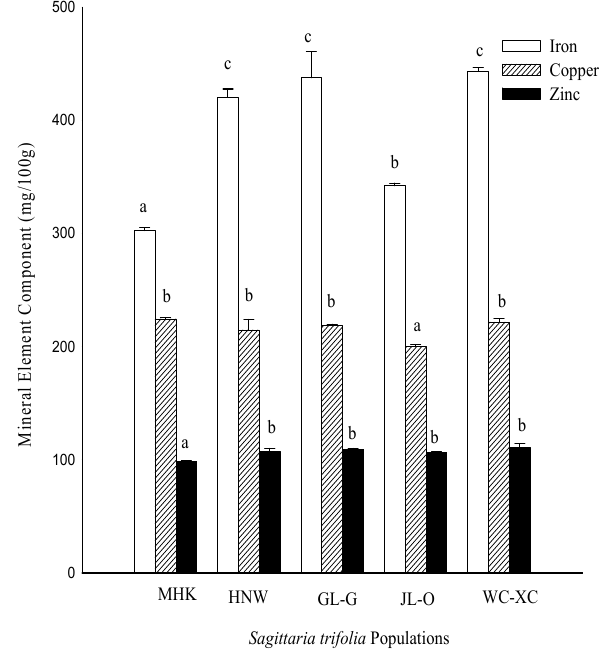
Figure 3. Mineral elements (%) in S. trifolia leaves. Values are represented as the mean ± standard error. The same letters within a column indicate that the mean values are not significantly different to the Tukey’s HSD test at p ≤ 0.05. MHK (Meihekou), GL-G (Jilin), JL-O (Siping), HNW (Harbin), WC-XC (Wuchang).